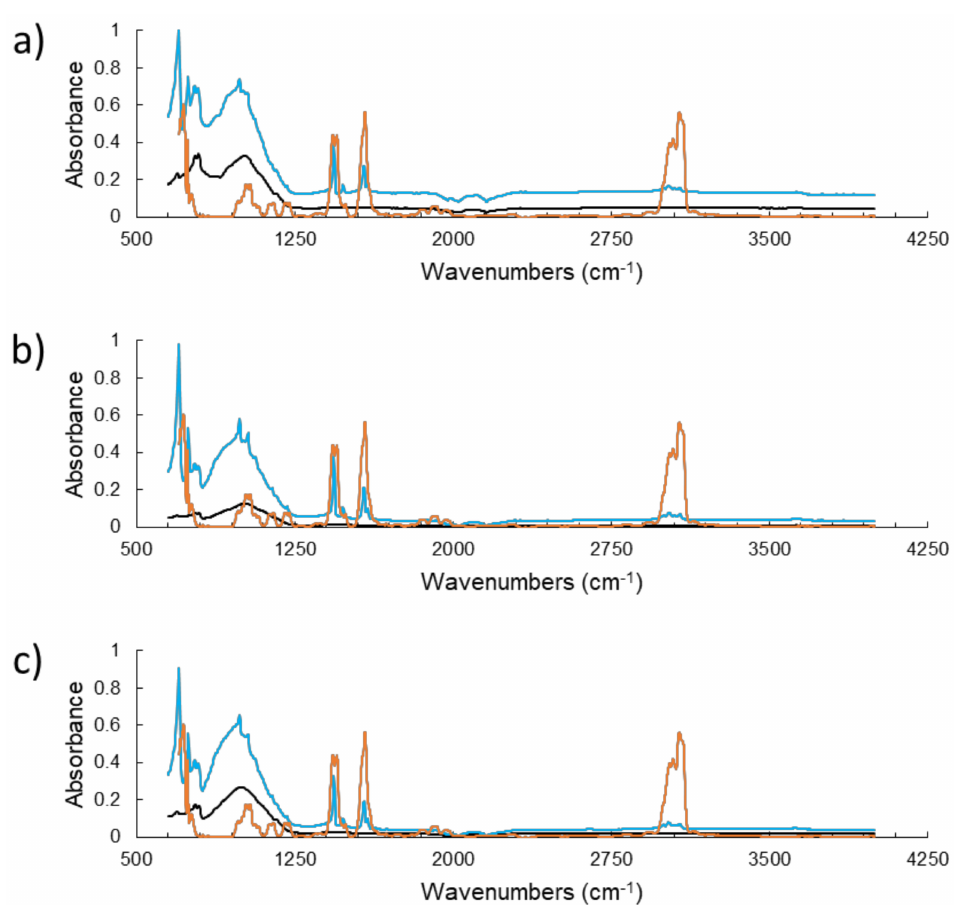
Figure 4. Fourier transform infrared (FT-IR) spectra of drill cuttings (black), drill cuttings containing absorbed pyridine (blue), and pure pyridine (orange). ( a ) raw drill cuttings, ( b ) control drill cuttings, ( c ) supported drill